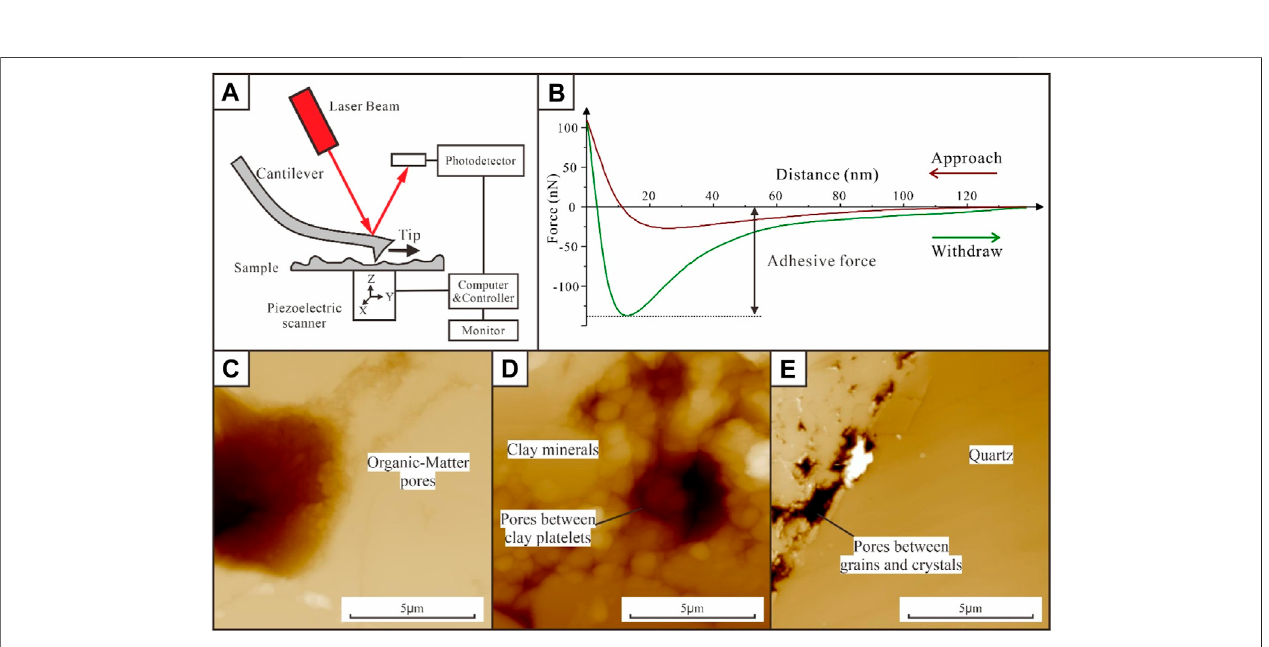
FIGURE 6 | Working principle of atomic force microscopy. (A) Experimental principle; (B) Schematic curve of force versus distance under the PeakForce QNM mode; (C) Organic matter pore morphology of JY4-05 (Wufeng Formation, 2,591.7 m); (D) Pore morphology of clay minerals; and (E) Intergranular pore morphology.